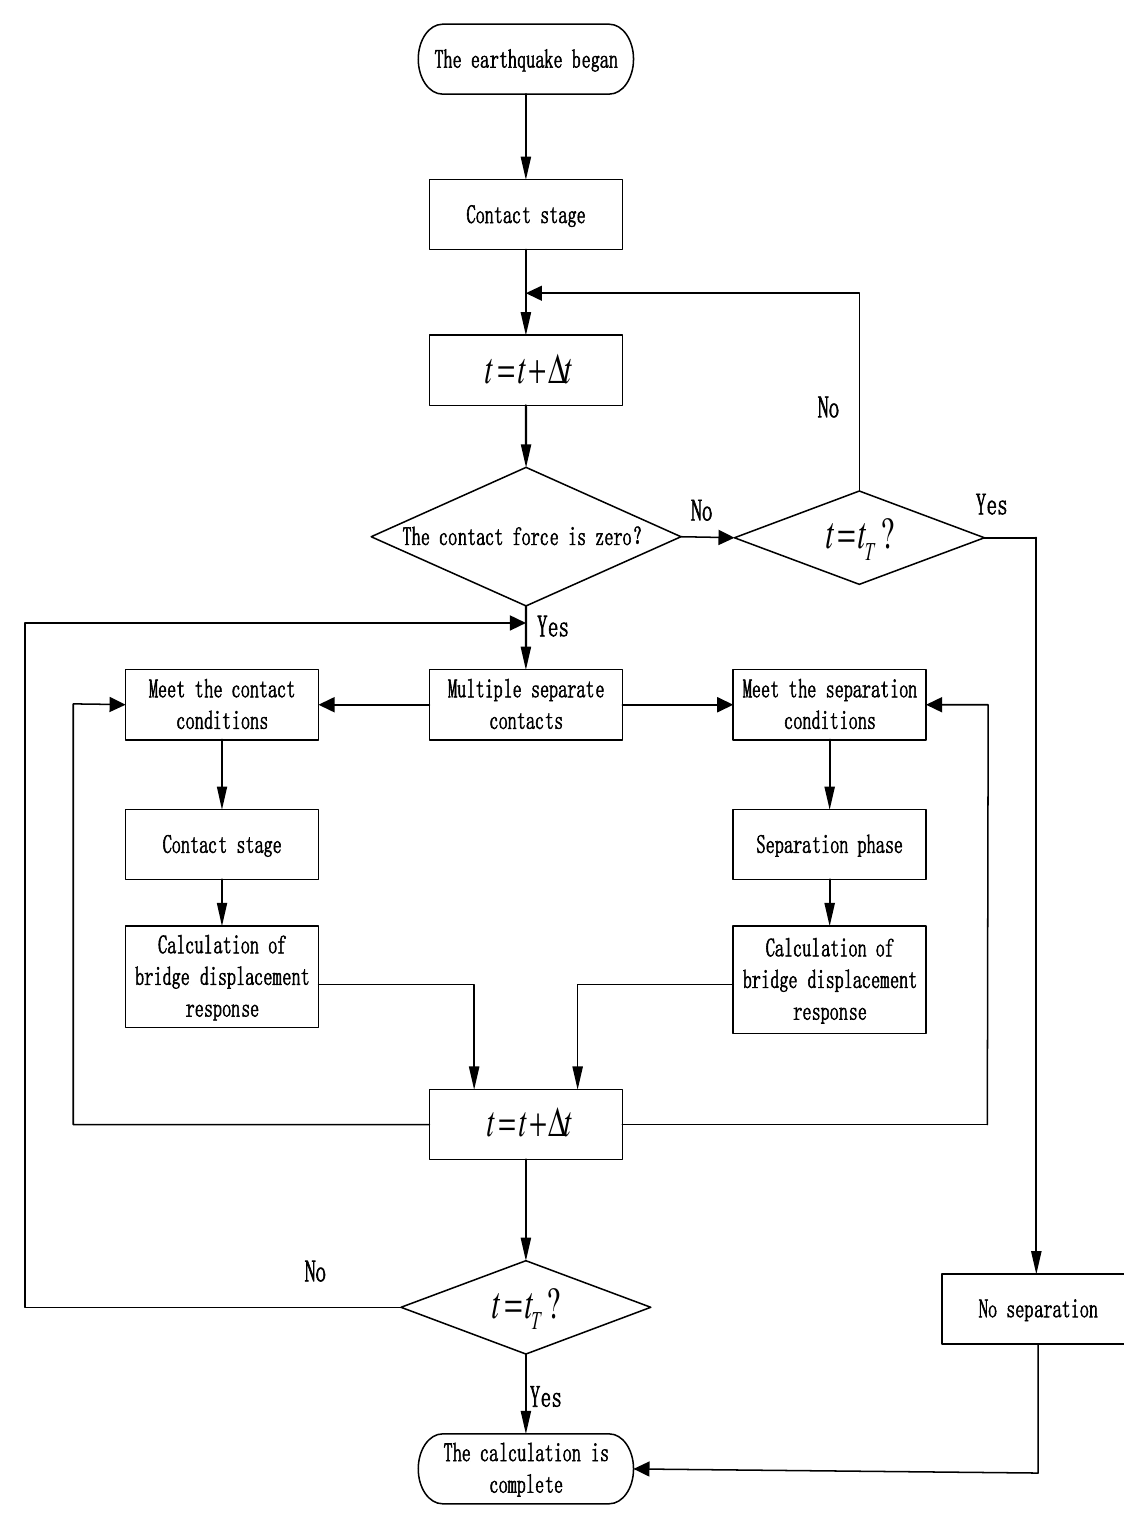
Figure 3. Flow chart showing bridge vertical displacement calculation procedure.